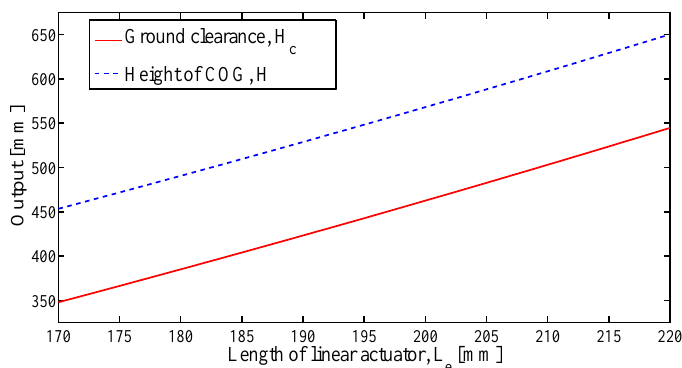
Figure 9. Input–output of the active